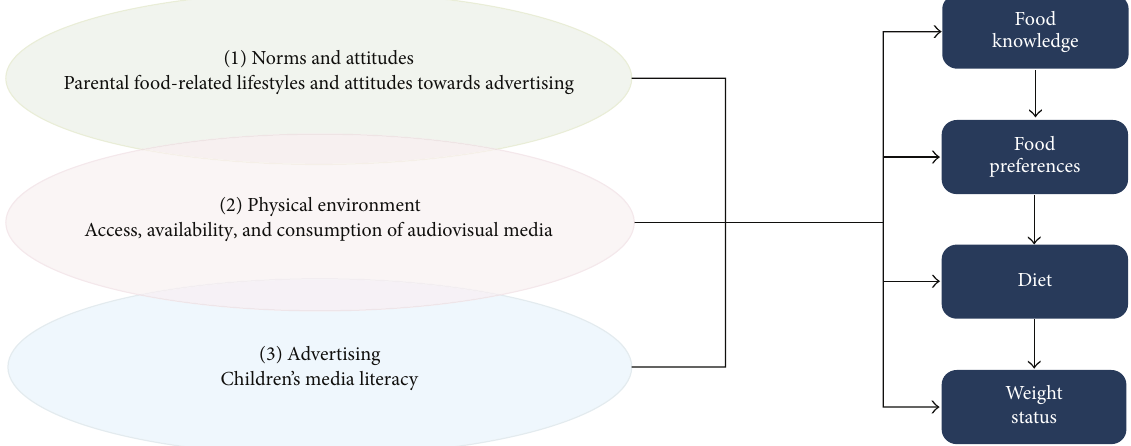
Figure 1: The role of commercial communication and food knowledge, preferences, diet, and weight status.